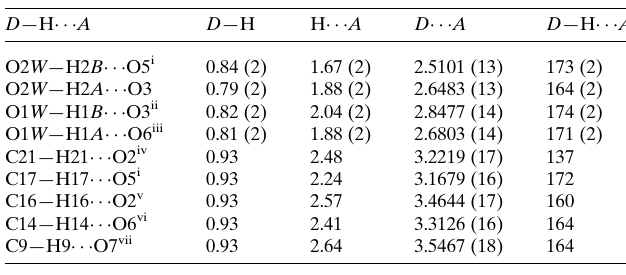
Table 1 Hydrogen-bond geometry (A˚ , (cid:4) ).